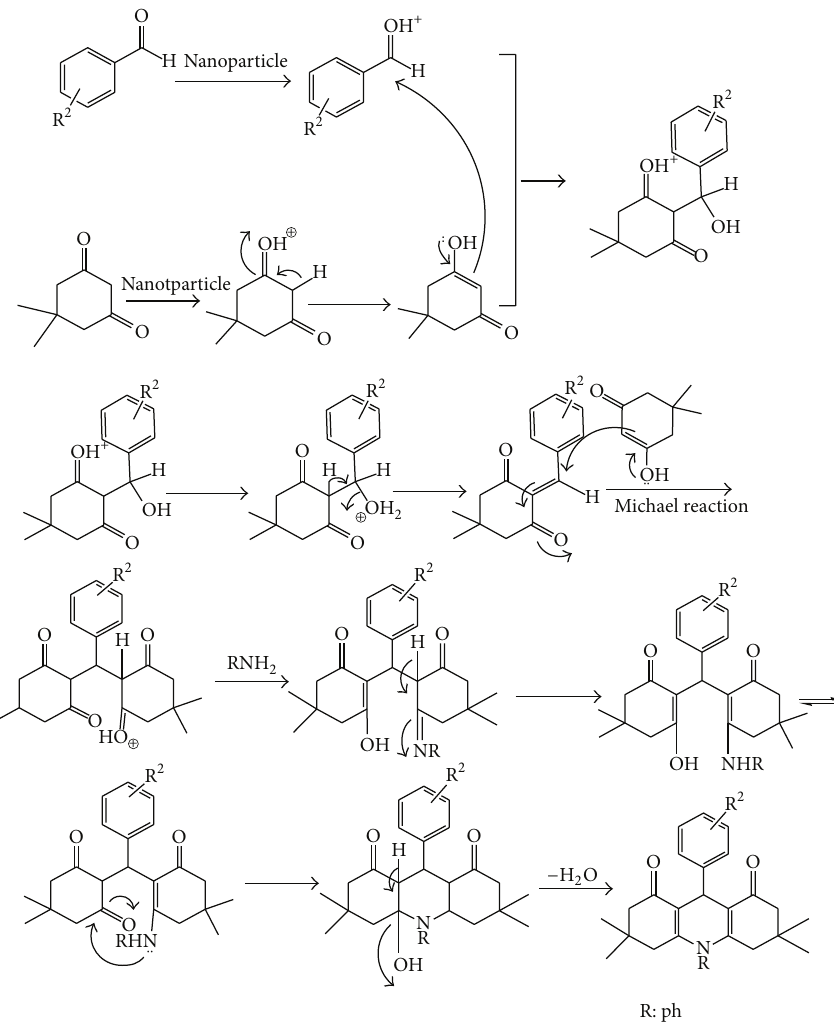
Scheme 2: The proposed mechanism of synthesis of 1,8-dioxodecahydroacridines.